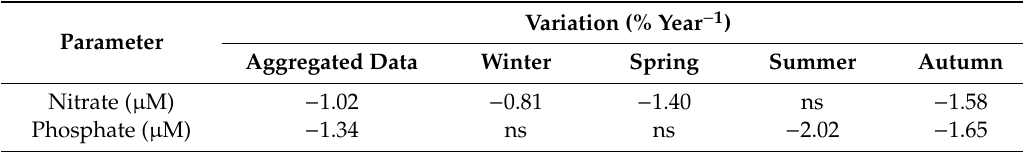
Figure 7. Seasonal surface trends of nitrate and phosphate concentrations in the Po River from 1993 to 2015. The blue line represents the long-term trend with the 95% confidence limits (gray range). When the slope was not significant ( p -value > 0.05), the long-trend line was not reported. Data from the Pontelagoscuro station provided by the ARPAE-ER. Table 3. Variation (% year − 1 ) of nitrate ( µ M) and phosphate ( µ M) in Po River flow as estimated by GLM regression. ns: variation not